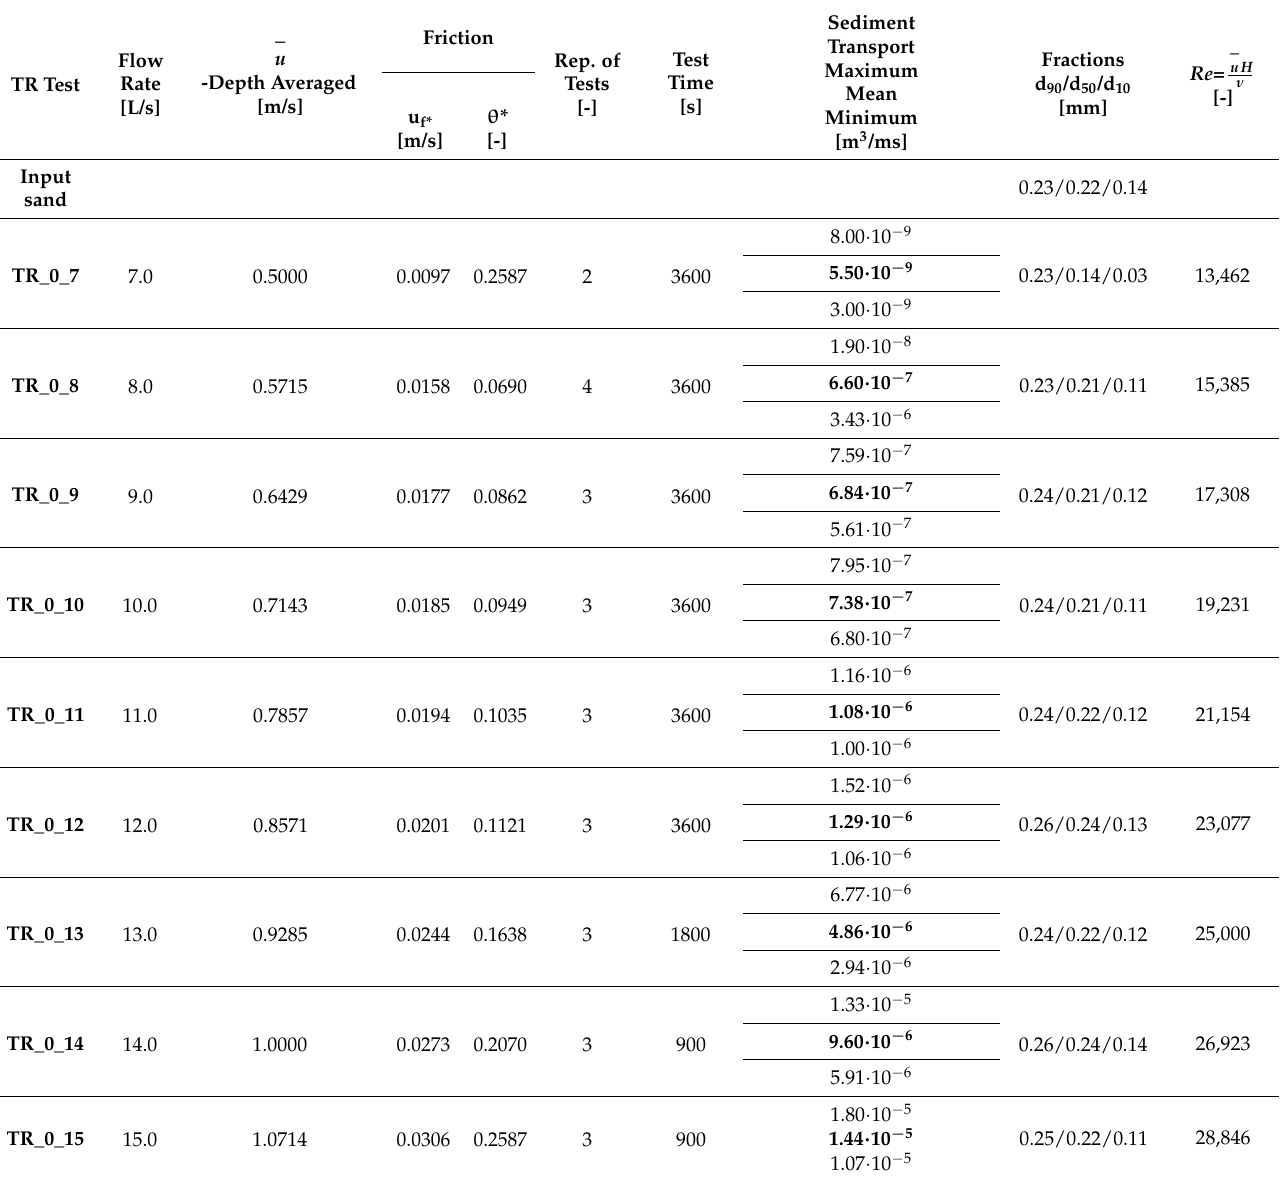
Table 1. Main parameters and transport results of the Gda´nsk 2021